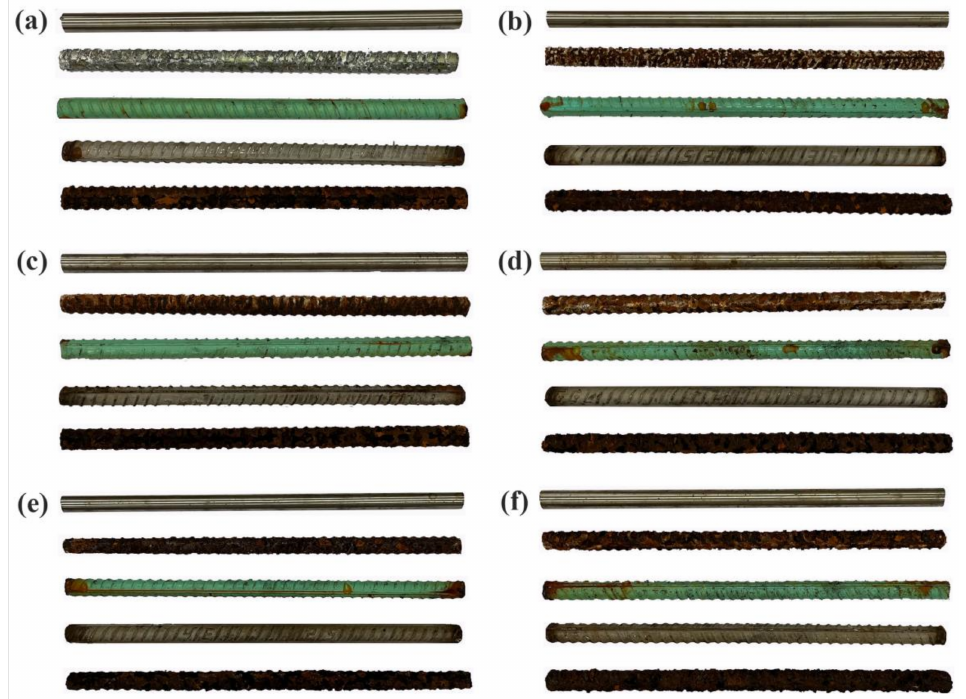
Figure 20. Surface profile of each specimen after various corrosion times: ( a ) 7 d; ( b ) 14 d; ( c ) 21 d; ( d ) 28 d; ( e ) 35 d; ( f ) 42